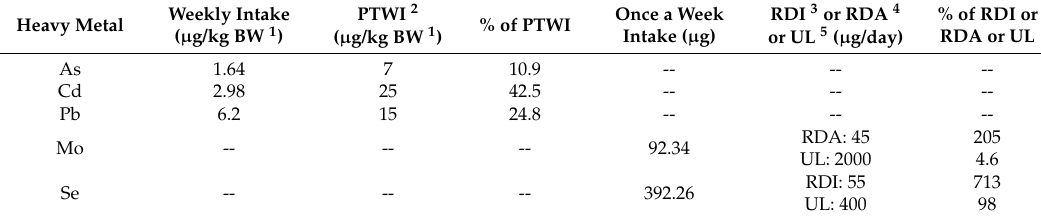
Table 7. Summary of the dietary exposure of the target study population to heavy metals from sheep meat protein and organ consumption representative of one day per